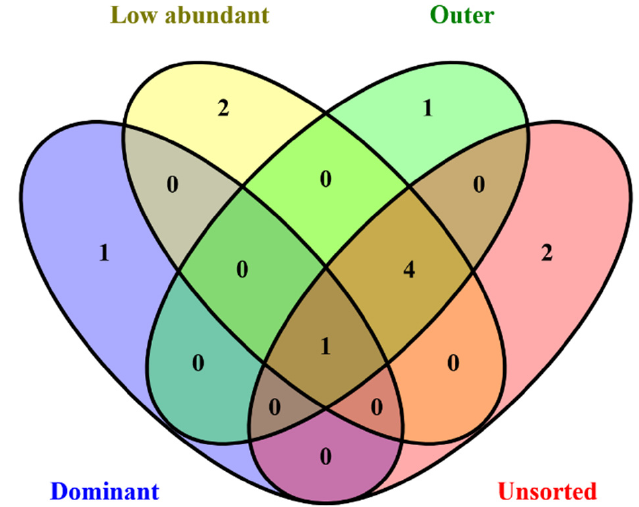
Figure 3. Venn diagram depicting the number of taxa observed shared between representative MAGs. It presents the number of taxa observed between MAGs recovered from unsorted and sorted sub-communities. One taxon was present in both the unsorted community and sorted sub-communities. Four taxa were found in the unsorted community and a combination of one or more sub-communities. Two taxa were present only in the unsorted community and five were exclusively found in the sorted sub-communities.